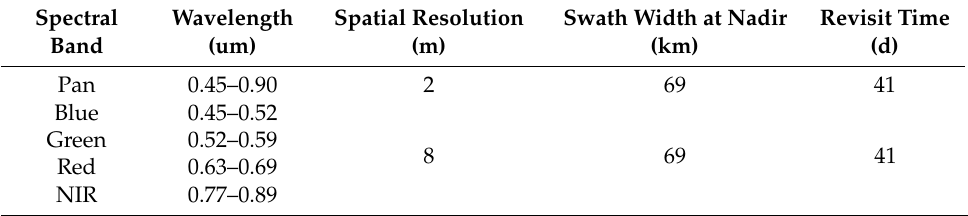
Table 1. Parameters of the 2 m panchromatic/8 m multispectral